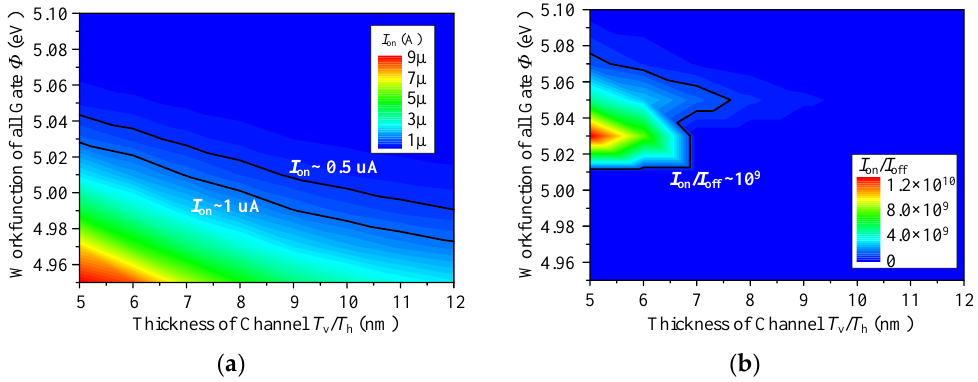
Figure 6. ( a ) The on-state current I on versus work function ϕ and body thickness T h / T v . ( b ) The I on / I off ratio versus ϕ and T h / T v .